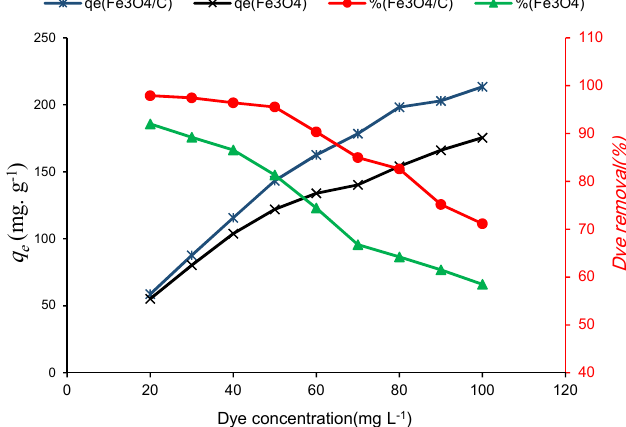
Fig. 13: Effect of dye concentration on the removal